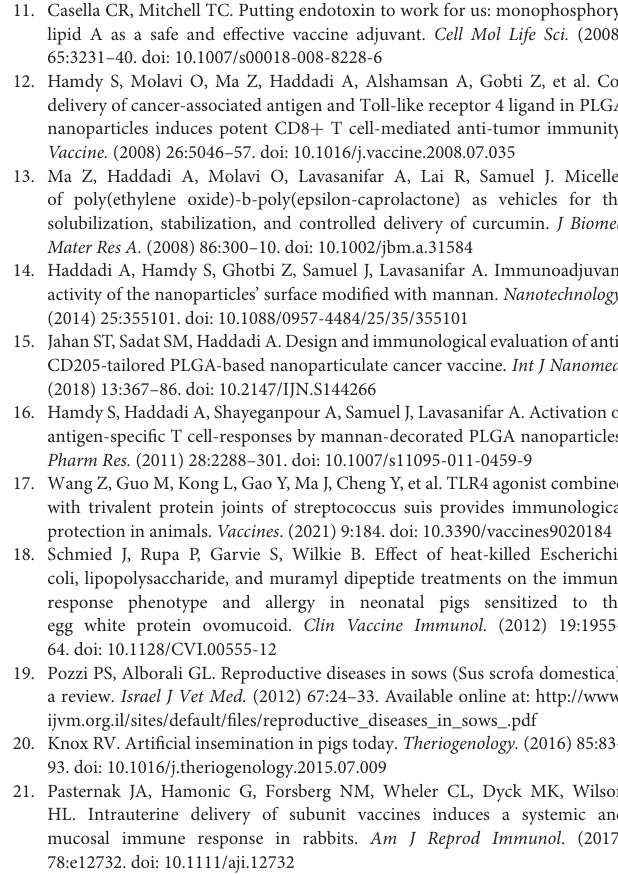
Supplementary Figure 1 | Serum antibody titers from animals vaccinated through the intramuscular route with or without prior intrauterine vaccination. Serum IgG (A) and IgA (B) antibody titers were collected 120 days post-breeding which would be 120 days post i.u. immunization and 90 days post i.m. immunization with PEDVS1 Nanoparticles. Negative control gilts did not receive any vaccine. Data are presented as median and standard deviation. Statistical analysis was carried out by the Kruskal-Wallis test and Dunn’s multiple comparisons test. Significant differences relative to the negative control gilt data are denoted by different asterisks ( ∗ p < 0.05, ∗∗ p <